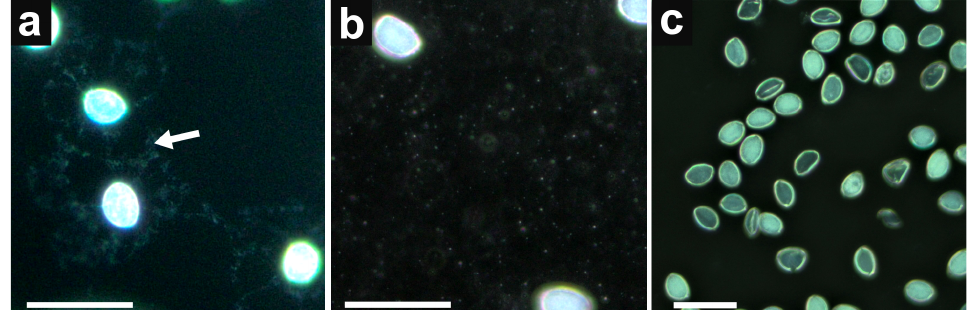
Figure 2. The dark field microscopy of pollen suspension. ( a ) pollen before washing—pollenkitt appears as a bright material around each pollen grain. White arrow pointing to the released pollenkitt from pollen grains; ( b ) supernatant after vortexing and centrifugation—pollenkitt is no longer accumulated around each pollen grain, but rather scattered into fine granular particles (appears here as bright white dots); ( c ) pollen suspension after washing—the pollenkitt is removed. Bars represent 50 µ m.